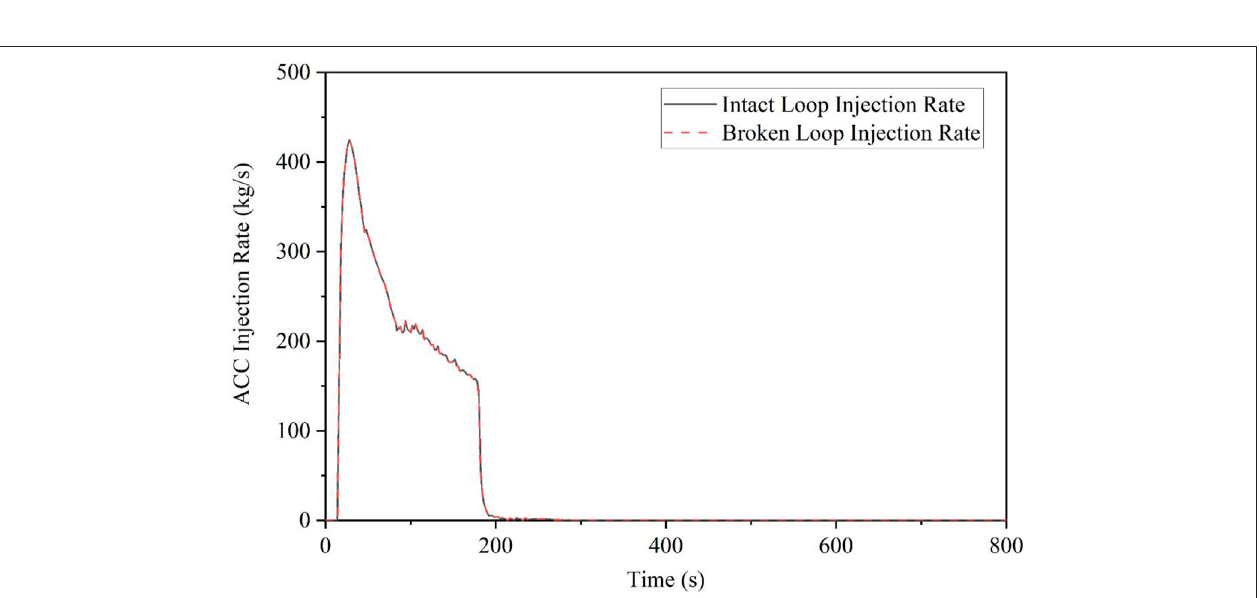
FIGURE 9 | Double-ended CL LBLOCA ACC discharge mass rate.